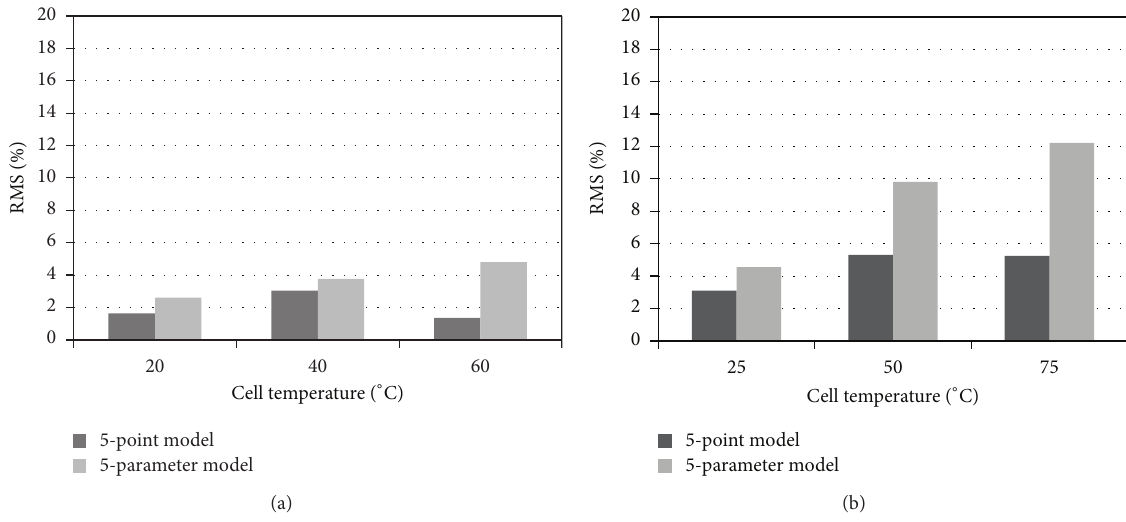
Figure 5: %RMS for Shell SP75 (a) and GES-P70 (b) at different temperatures, 1000W/m 2